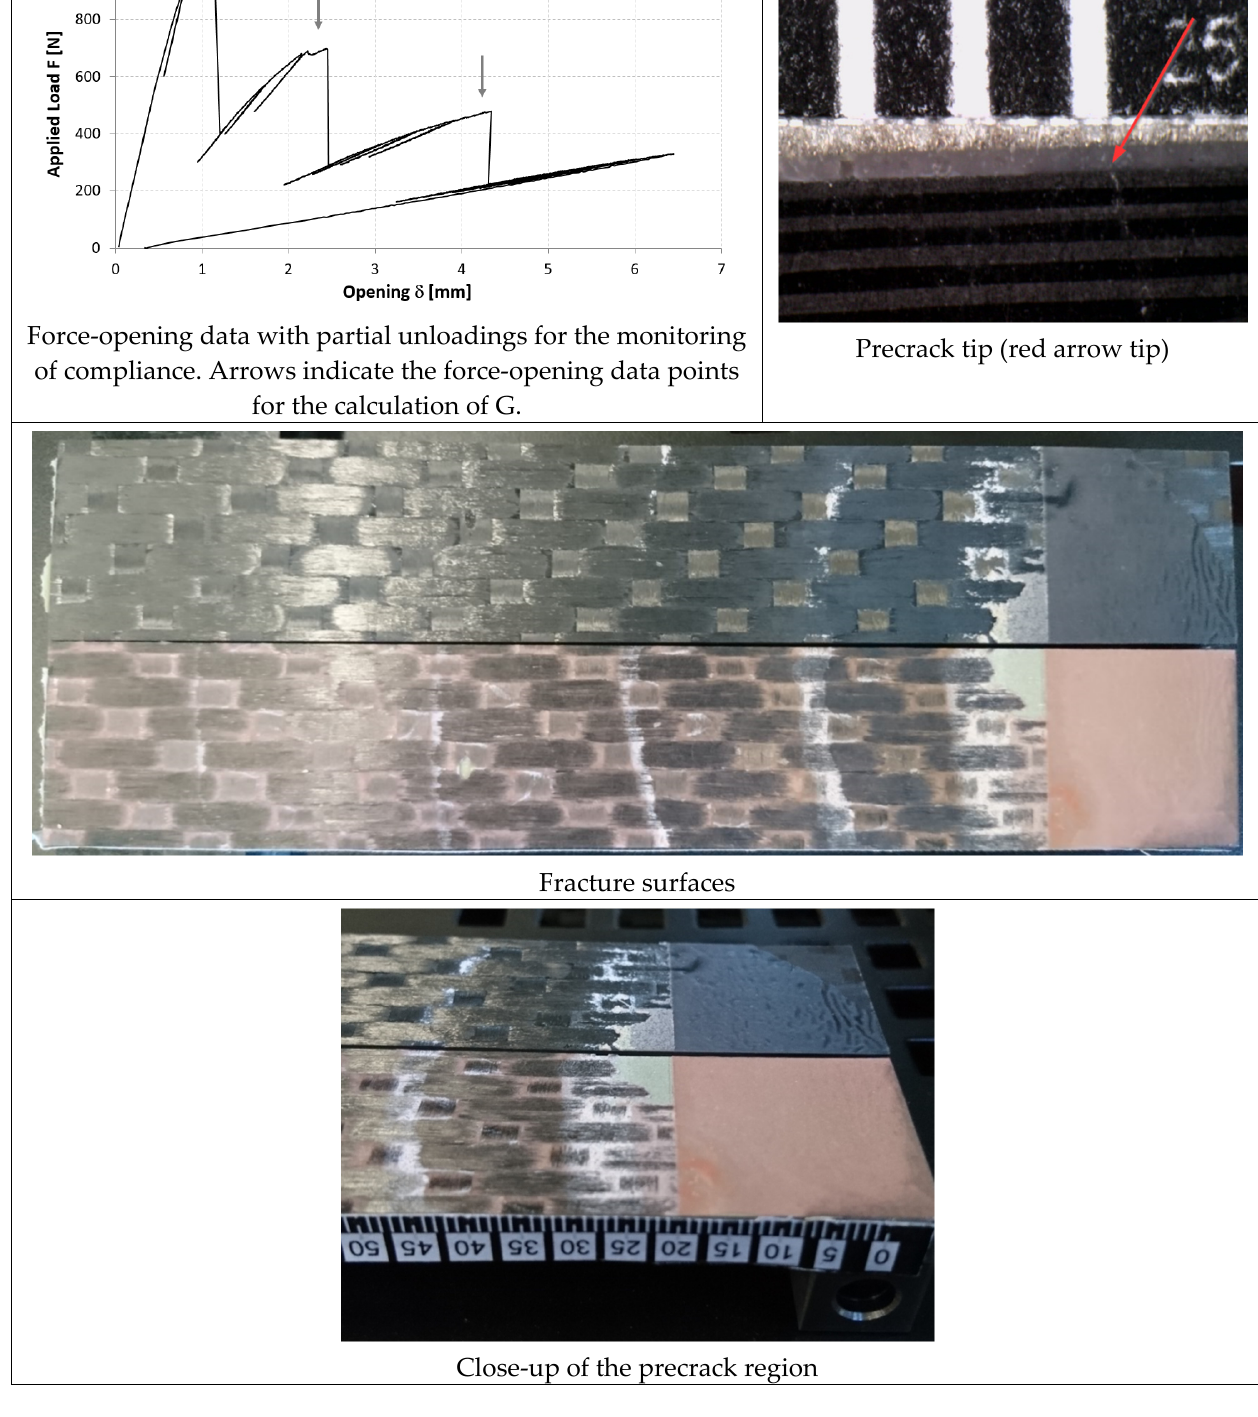
Figure 19. Results of the test on specimen DCB_9323_03.